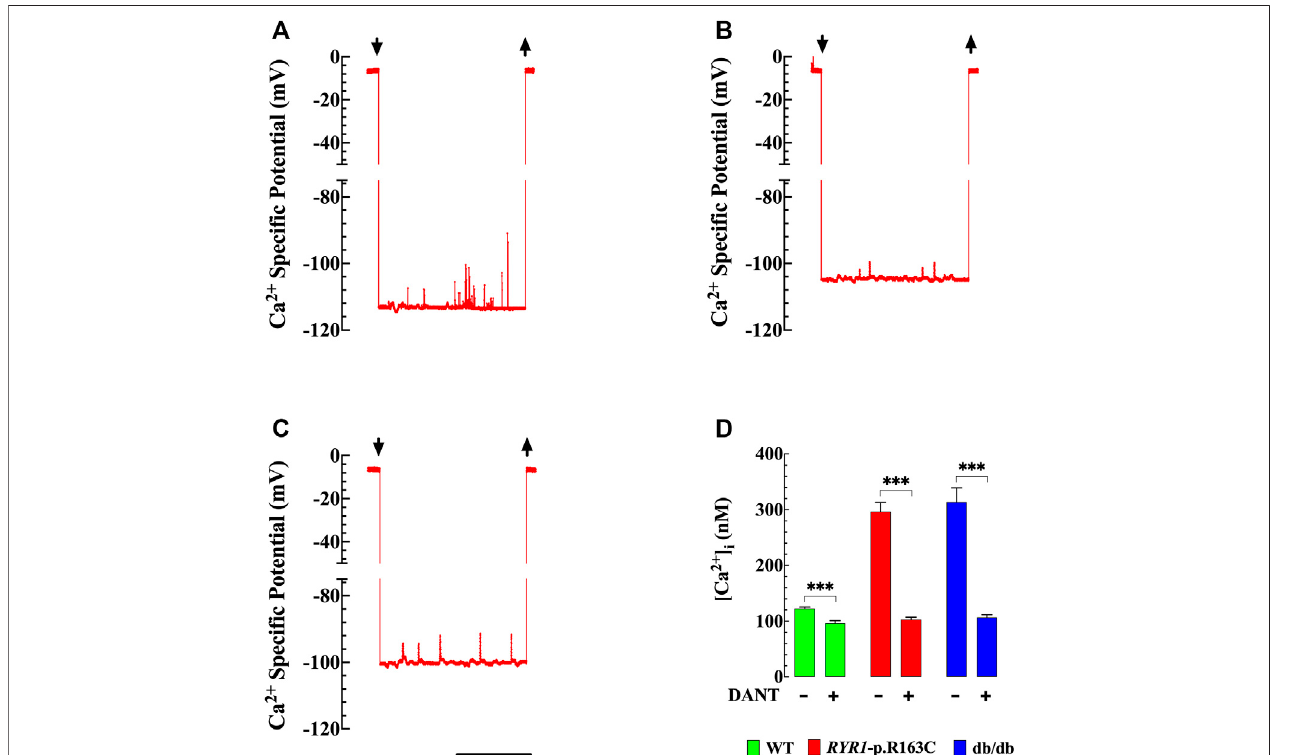
FIGURE 4 | [ Ca 2+ ] i in intact skeletal muscle cells. Effect of dantrolene. The records represent the speci fi c potential of Ca 2+ obtained from WT, RYR1 -pR163C, and db/db muscle cells. [Ca 2+ ] i was calculated using the corresponding microelectrode calibration curve (Lopez et al., 1983). (A) Shows a representative record of the Ca 2+ speci fi c potential obtained from a WT muscle cell, [Ca 2+ ] i was 119 nM. The upper left and right arrows indicate Ca 2+ microelectrode impalement and withdrawal, respectively; (B) Ca 2+ speci fi cpotential recorded from RYR1 -pR163C muscle fi ber, [Ca 2+ ] i was 284 nM; (C) Ca 2+ speci fi c potential recorded from a db/db muscle fi ber; [Ca 2+ ] fi cantly higher in RYR1 -pR163C and db/db than WT muscle cells. Dantrolene treatment (1.5 mg/kg IP daily for 2 weeks) 2+ ] i was 329 nM. (D) [Ca i was signi reduced [Ca 2+ ] i in all genotypes; however, the reduction was greater in RYR1 p . R163C (2.8 times) and db/db (2.9 times) than in WT muscles (1.2 times). Values are expressed as mean ± S. D; experiments were carried out in n mice = 6 per genotype; n cells = 13 – 16/genotype group. Statistical analysis was performed as described above. *** = p < 0.001. Calibration bar = 1